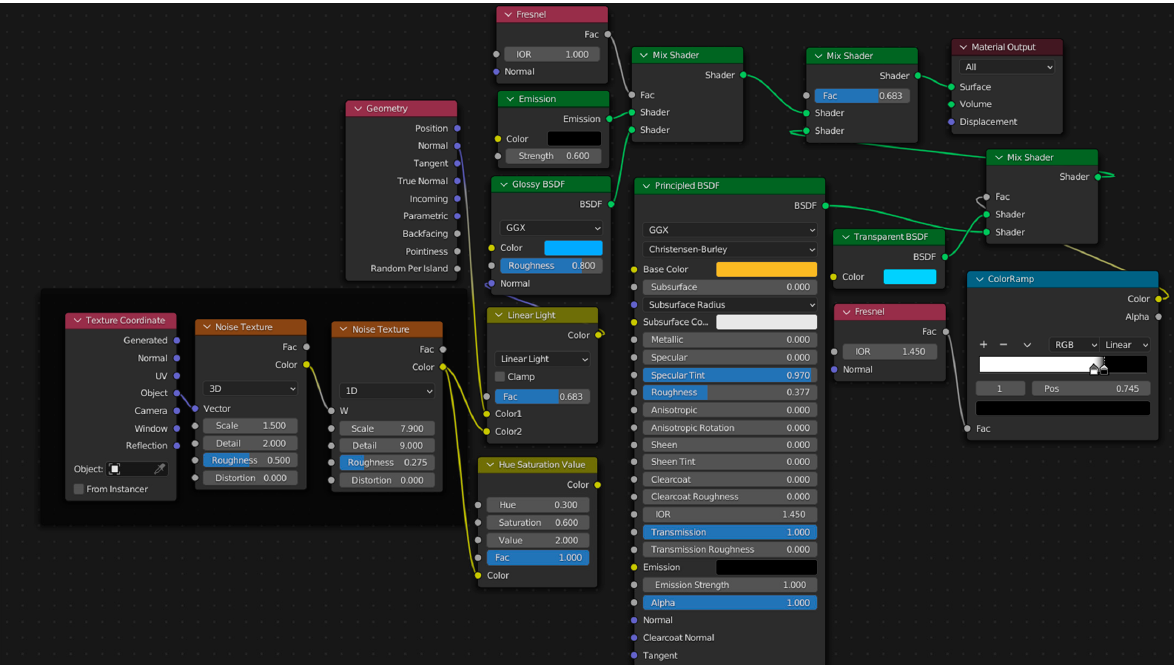
Figure 3. The monodisperse droplet material shader.